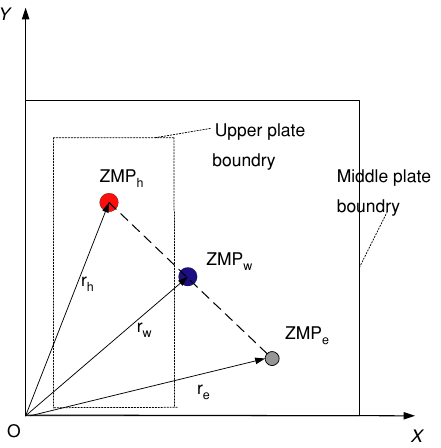
Figure 6 Distribution of the sensors. Figure 7 Relationship between the human ZMP and the exoskeleton’s ZMP.